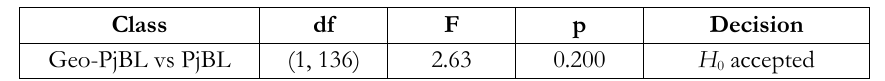
Table 2. Results of Consistency Test